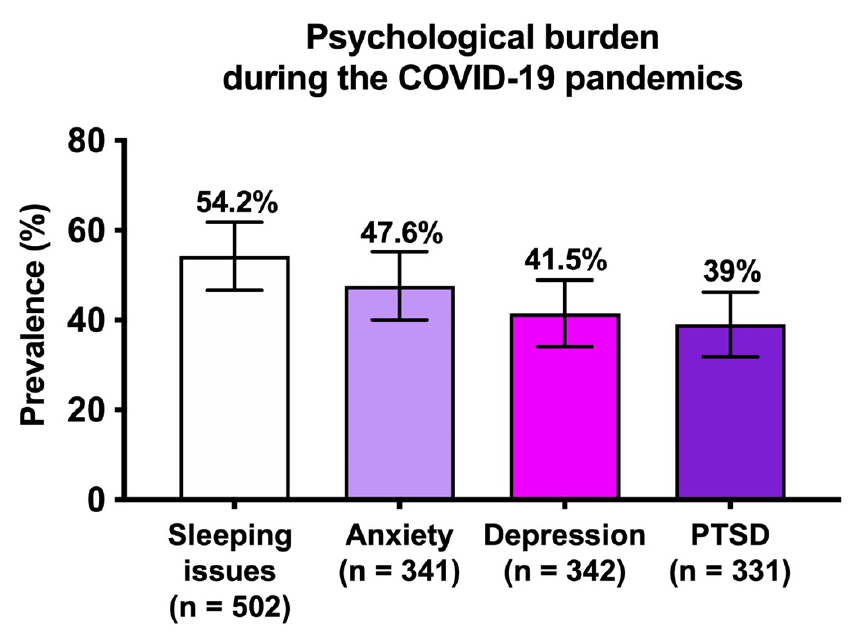
Figure 1. Prevalence of psychiatric disorders in SLE patients during the COVID-19 pandemic. Columns show mean and bars represent the standard deviation. Abbreviation: PTSD, post-traumatic stress disorder. Table 3. Factors associated with the development of anxiety, depression, or PTSD. Odds ratio (CI95%) using multivariate logistic regression are shown.